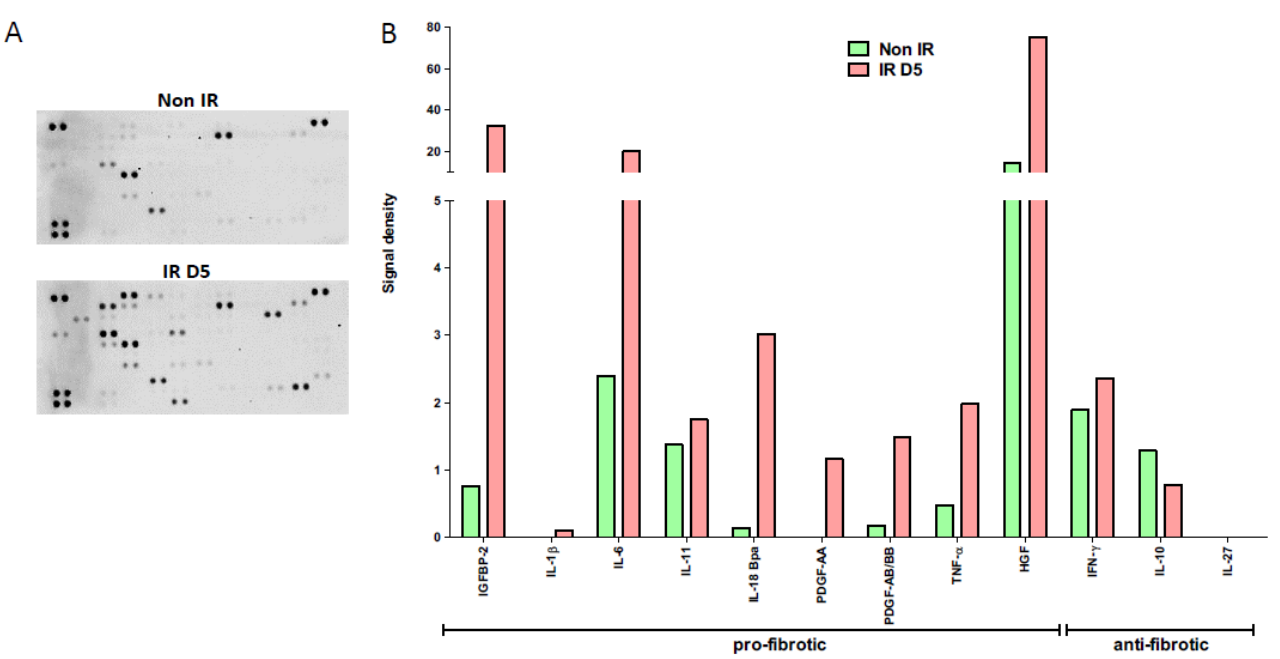
Figure 6. Profiling of cytokines expressed by secretomes of irradiated or non-irradiated fibro- blasts obtained with Proteome Profiler Human XL cytokine Array Kit (R&D) ( A ) Representative image of dot blot, ( B ) graph showing signal density of dot blot for each protein normalized to positive spot pixels.